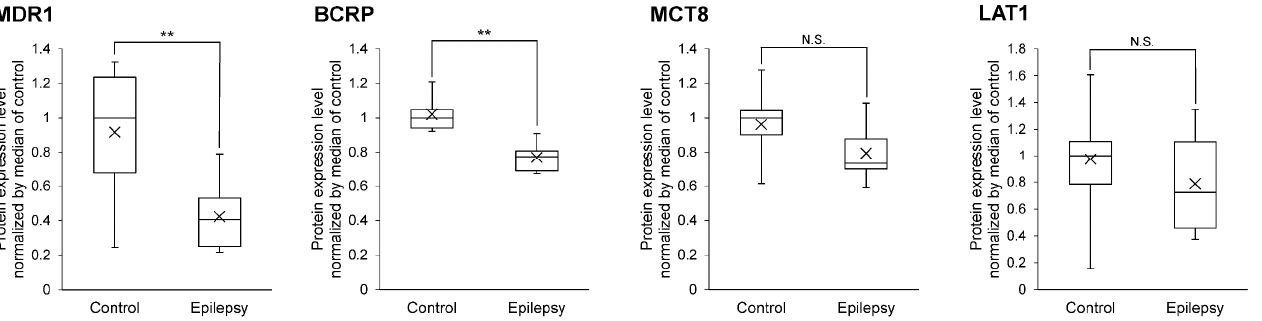
Figure 1. Protein expression level of the AED transporters in epileptic brain capillaries compared to controls. Brain capillaries were isolated from focal sites in six epilepsy patients and five normal brains; tryptic digests were produced and subjected to SWATH analysis. The band inside the box represents the median, and the bottom and top of the box indicate the first and third quartiles, respectively. Whiskers indicate the minimum and maximum values of the protein levels. X plots show the average in each group. The data are normalized by the median for the protein expression level in controls. ** BH-adjusted p value < 0.01, significantly different between epilepsy and control groups. N.S., not significantly different. MDR1, Multidrug resistance protein 1; BCRP, Breast cancer resistance protein; LAT1, L-type amino acid transporter 1; MCT8, Monocarboxylate transporter 8.